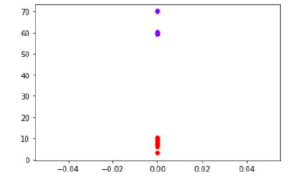
Fig. 9. K-means clustering to divide the gap between the